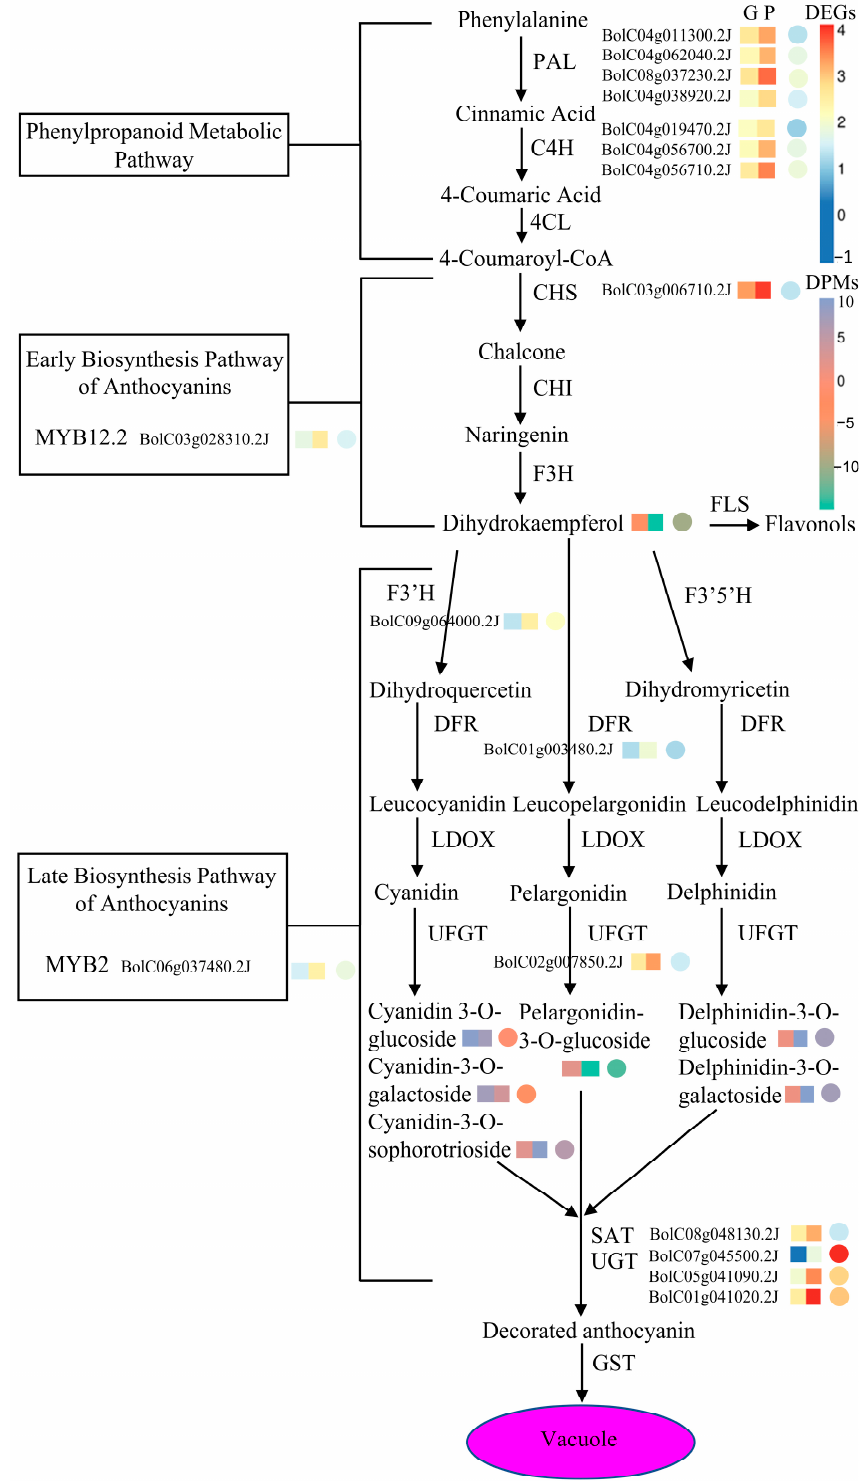
Figure 6. Genes and metabolites involved in anthocyanin biosynthesis in broccoli. The color scale next to the genes and metabolites indicates significant differences in their expression levels (FPKM) and relative contents (RC), respectively. The square color scale represents log10 FPKM of genes or log10 RC of metabolites and the circle color scale represents the log2foldchange of genes or metabolites.